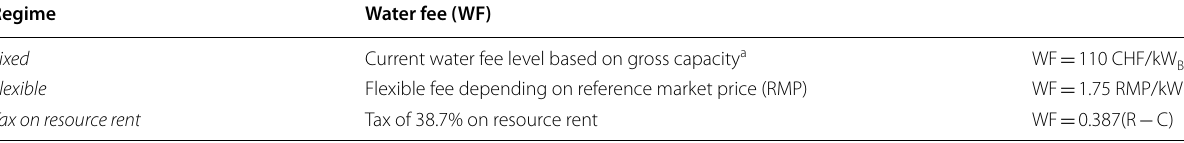
Based on Swiss Federal Council (2017) and SFOE (2018a, b). kW Br stands for kW of gross capacity a The maximum water fee level allowed by federal regulation is set at 110 CHF/kW Br . Only the cantons of Bern, Jura, Zug, and Vaud stayed below this tax level (Swiss Federal Council, 2018). For our analysis, we use the observed water fee payments in 2015/16. As the flexible water fee payments are calculated in relation to observed payments, we assume that these cantons continue to have a relatively lower tax level